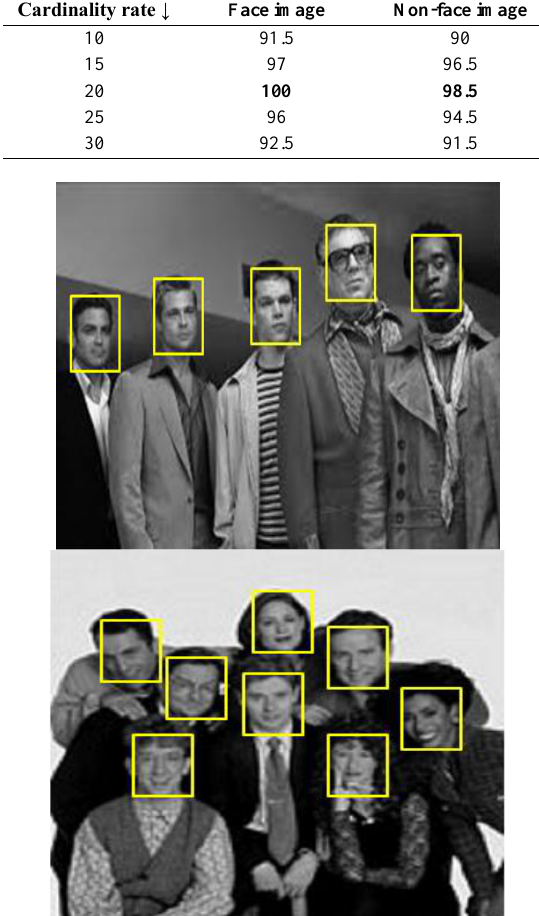
Figure 6. Face detection results by the proposed detection algorithm based on the extracted combinational feature GLCM/HOG/LBP/Moment.